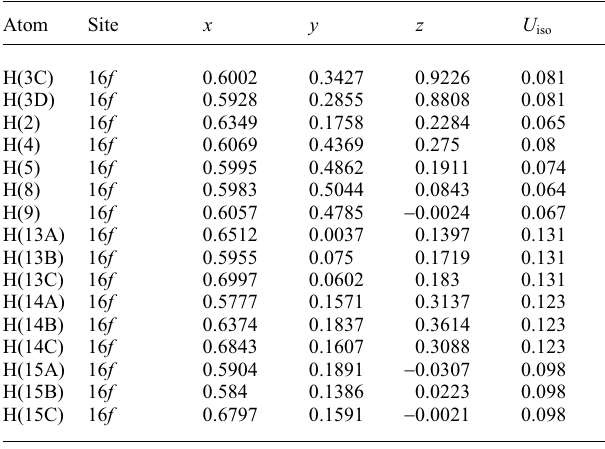
Table 2. Atomic coordinates and displacement parameters (in Å 2 )